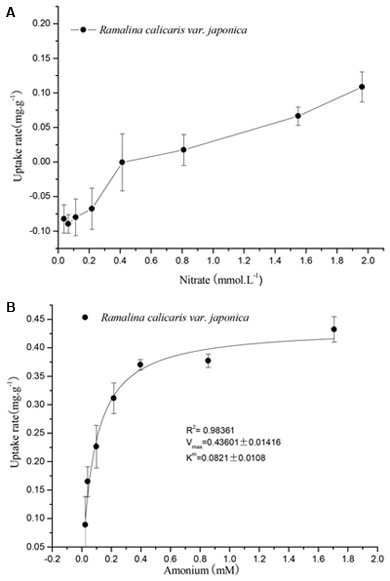
Response of nitrate (A) and ammonium (B) uptake of R. calicaris var. japonica to nitrogen availability (Mean ± SD, n = 5).